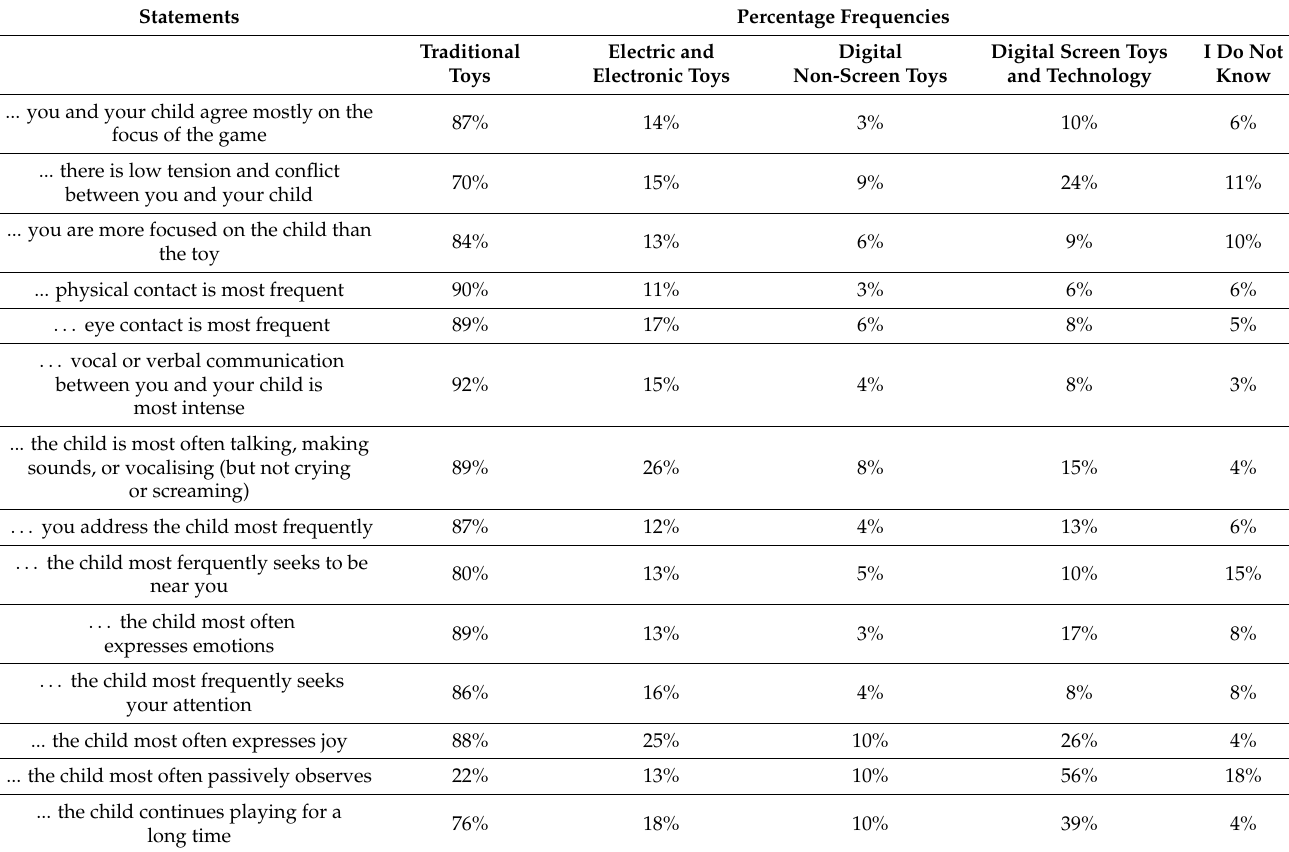
Table 5. Parent–child interaction accompanying play—analogue vs.